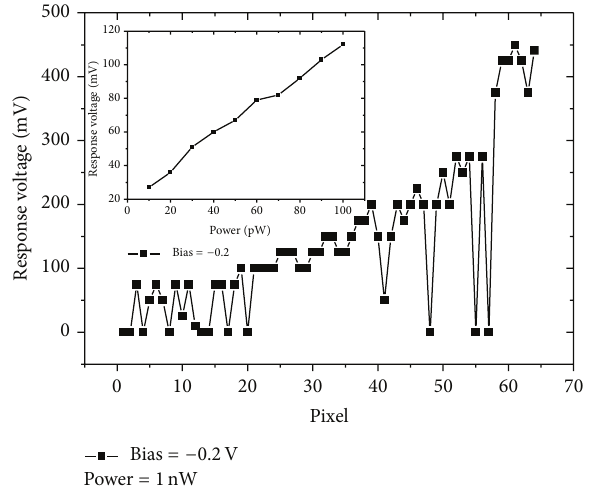
Figure 5: Readout voltage of the 64-pixel linear array at 1nW illuminated beam (633 nm) power. The inset shows the 61th pixel response voltage at indoor temperature and laser (633 nm) power changed from 10 pw to